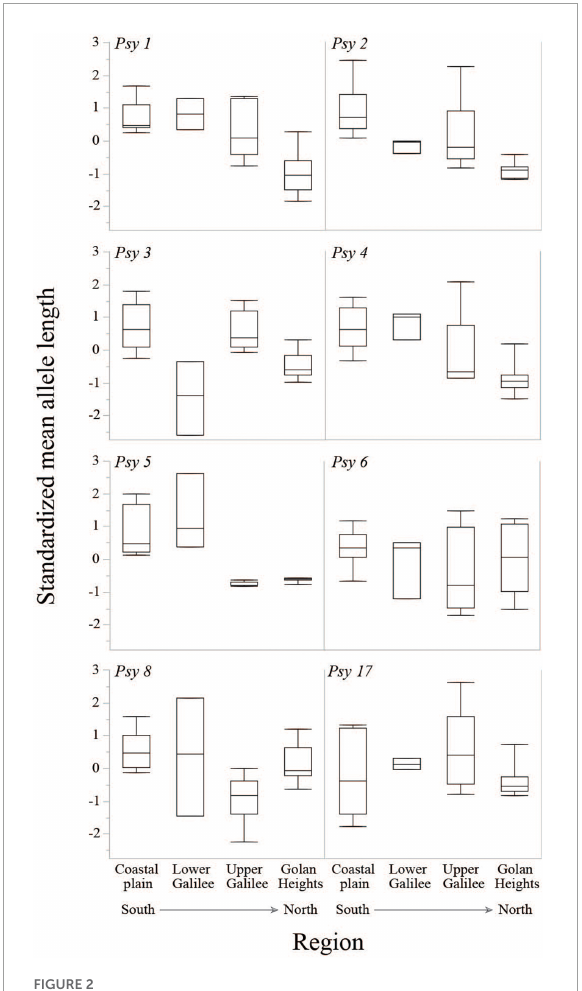
FIGURE2 Quantile box plots for standardized mean allele length for region and locus. Regions are ordered from south to